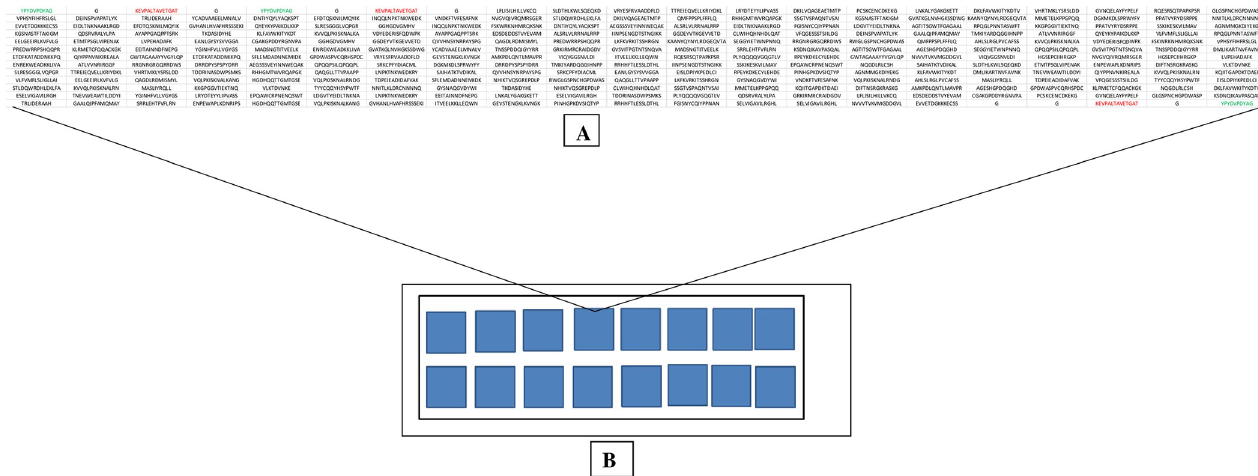
Fig 1. Peptide microarray chip design and layout. ( A ) Microarray peptide content, in black are 130 selected peptides printed with random distribution in duplicate to give 260 spots and in green and red are 3 HA and 3 Polio internal control spots. ( B ) Peptide microarray layout with 16 identical array copies